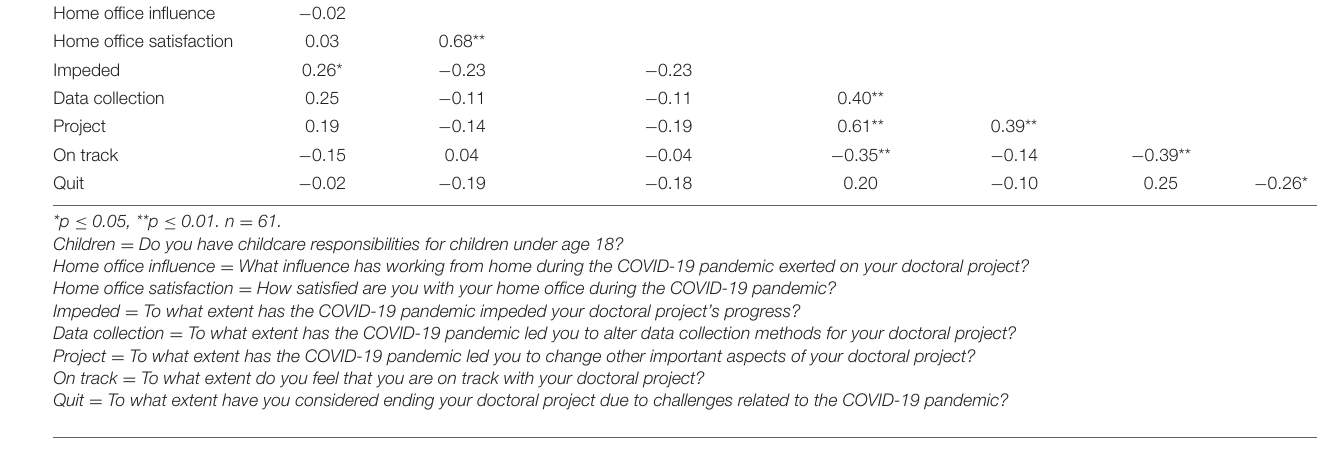
TABLE 4 | Project status and supervision : Spearman’s rank